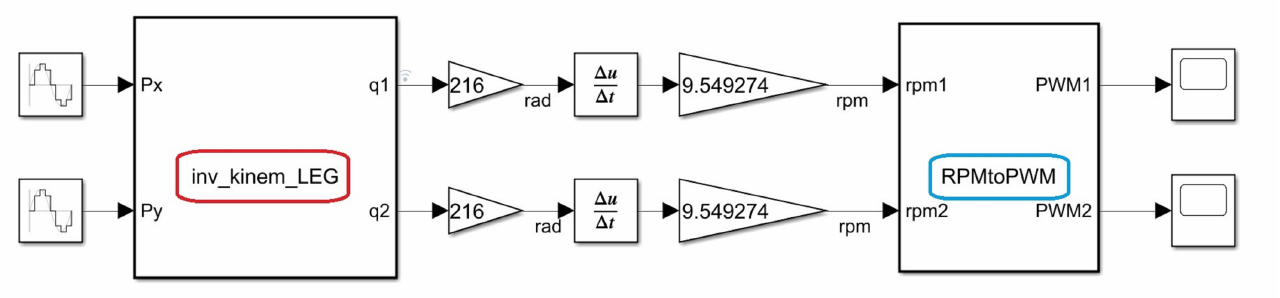
Figure 13. Polynomial regression curve: rpm–PWM. Inverse kinematic block results sent the angular position signal multiplied by a con- stant 6 3 (by three gearbox stages). This signal was used to obtain the angular velocity (see Figure 14). With Equation (9), the PWM data were obtained for the setpoint.